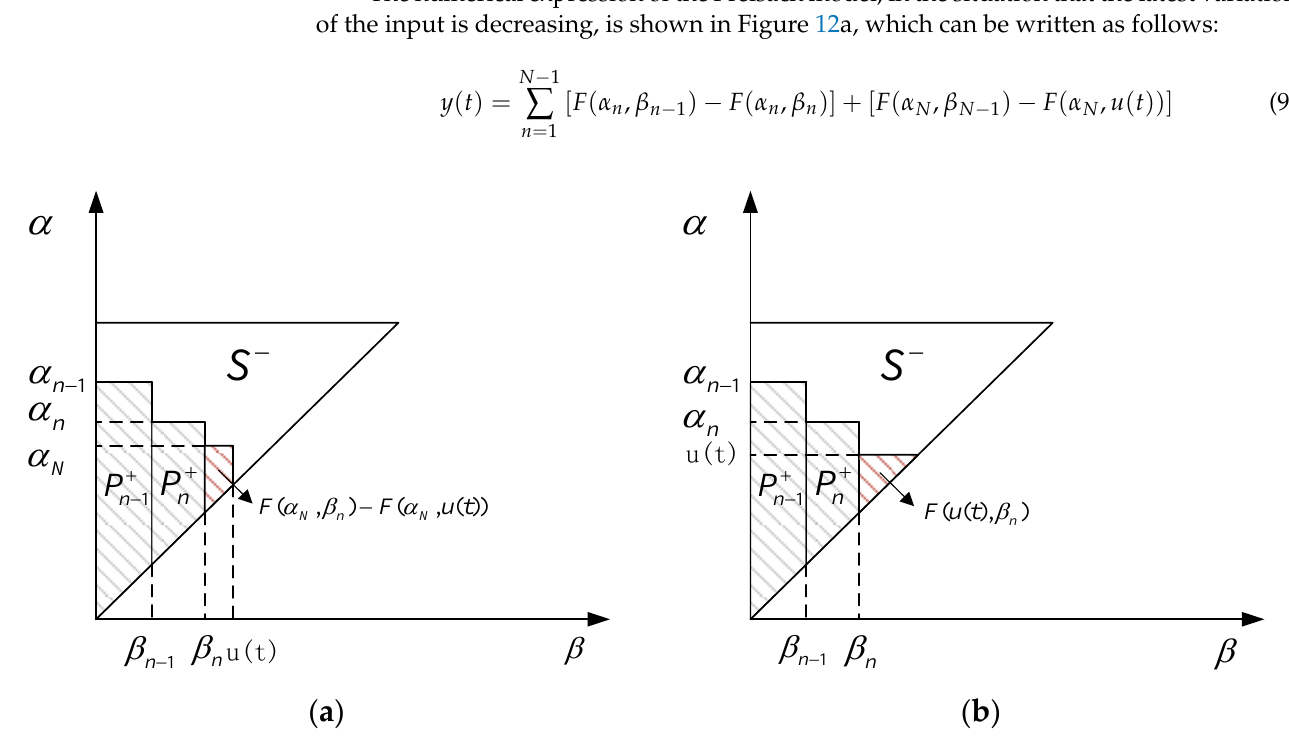
Figure 12. The situations of the last variation of the input. (a)the latest variation of input is decreasing; (b)the latest variation of input is increasing.